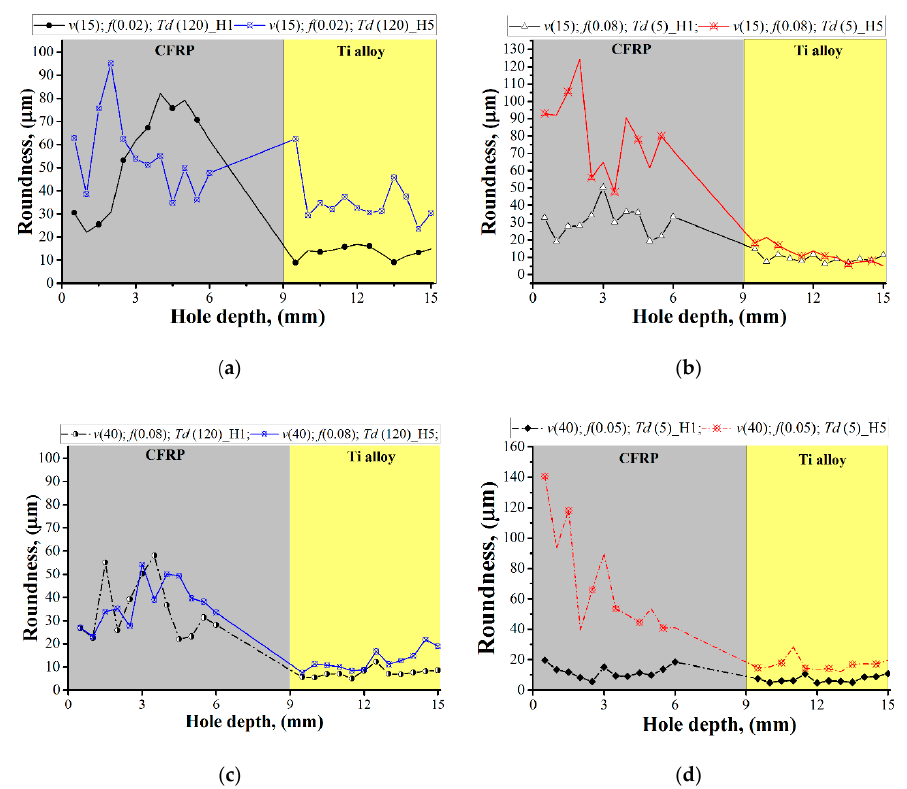
Figure 8. The effect of the time delay factor on hole roundness. ( a , c ) Comparison of hole roundness for holes No. 1 and No. 5 drilled under CDM conditions; ( b , d ) comparison of hole roundness for holes No. 1 and No. 5 drilled under HDM conditions.